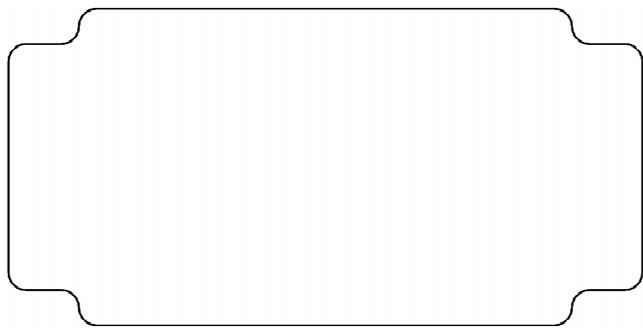
Figure A17. Spiral Fabric Design KB-6. Kirigami blank, Thermionyx fabric.